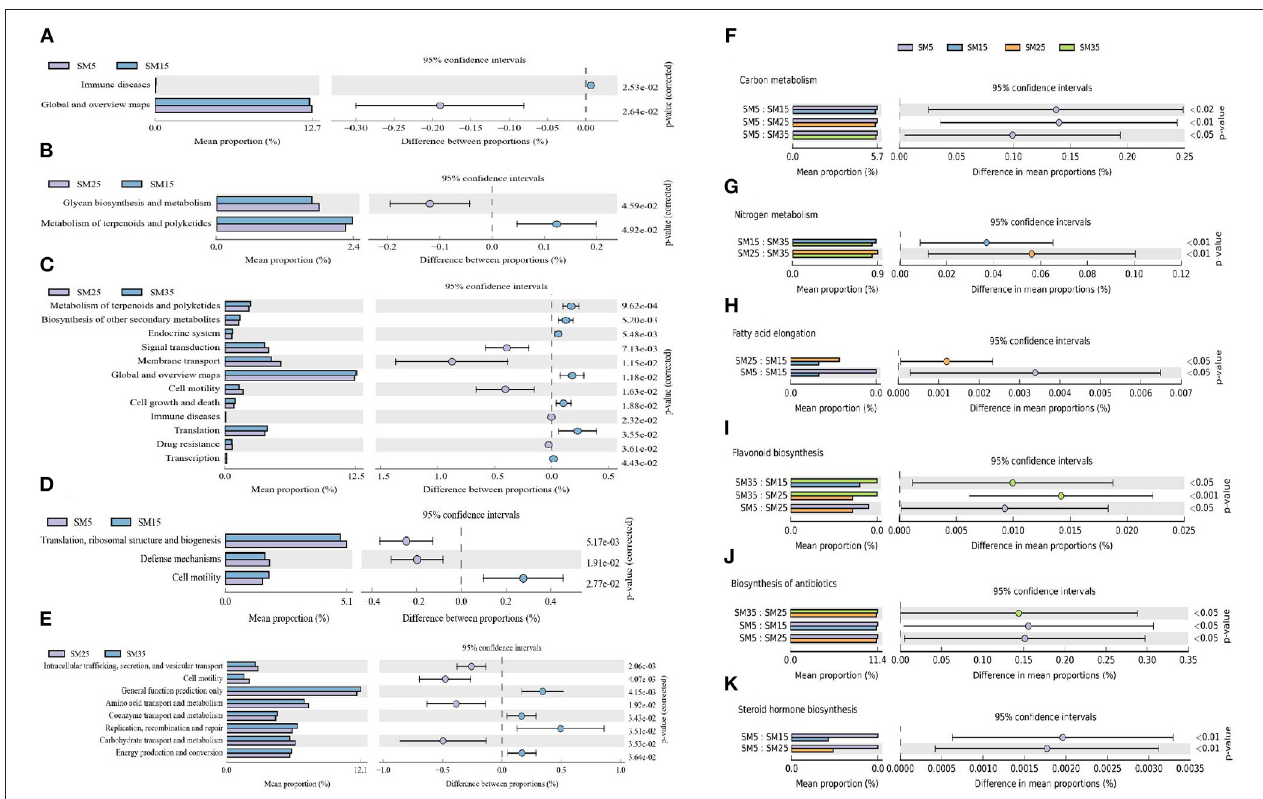
FIGURE 5 | Changes in bacterial functional genes predicted by PICRUSt based on KEGG pathways (A–C,F–K) and Clusters of Orthologous Groups (COG) analysis (D,E) that differed significantly in pairwise comparisons of Chinese fir stands of different ages. (F–K) involved in (F) carbon metabolism; (G) nitrogen metabolism; (H) fatty acid elongation; (I) flavonoids biosynthesis; (J) antibiotic biosynthesis; and (K) steroid hormone biosynthesis, based on third-tier KEGG pathways. SM5, SM15, SM25, and SM35 represent stand ages of 5, 15, 25, and 35 years,